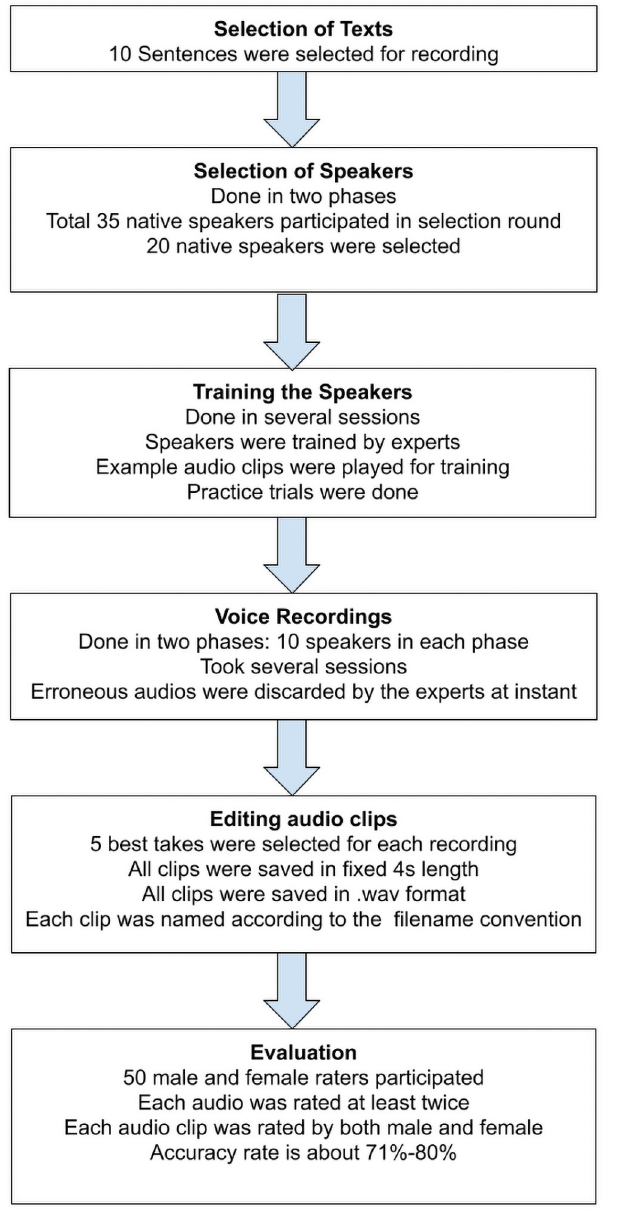
Fig 1. Flowchart of preparation of